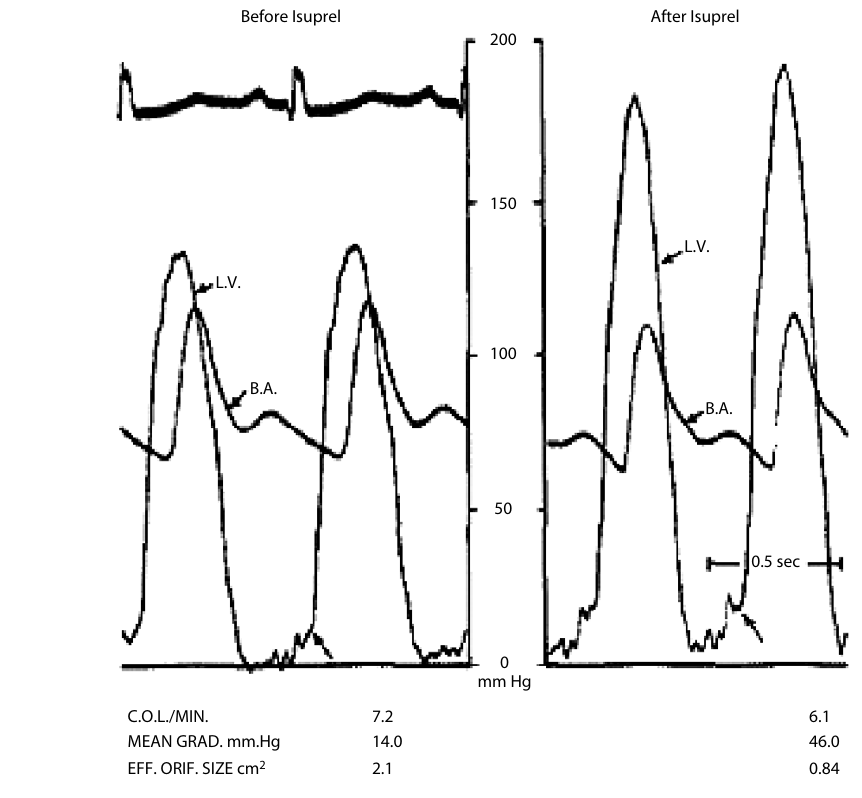
Figure 3. Hemodynamic effects of 2 µ g isoproterenol. Isuprel = isoproterenol, C.O. = cardiac output, Grad. = gradient, Eff. Orif. = effective orifice (Ref. [10]).